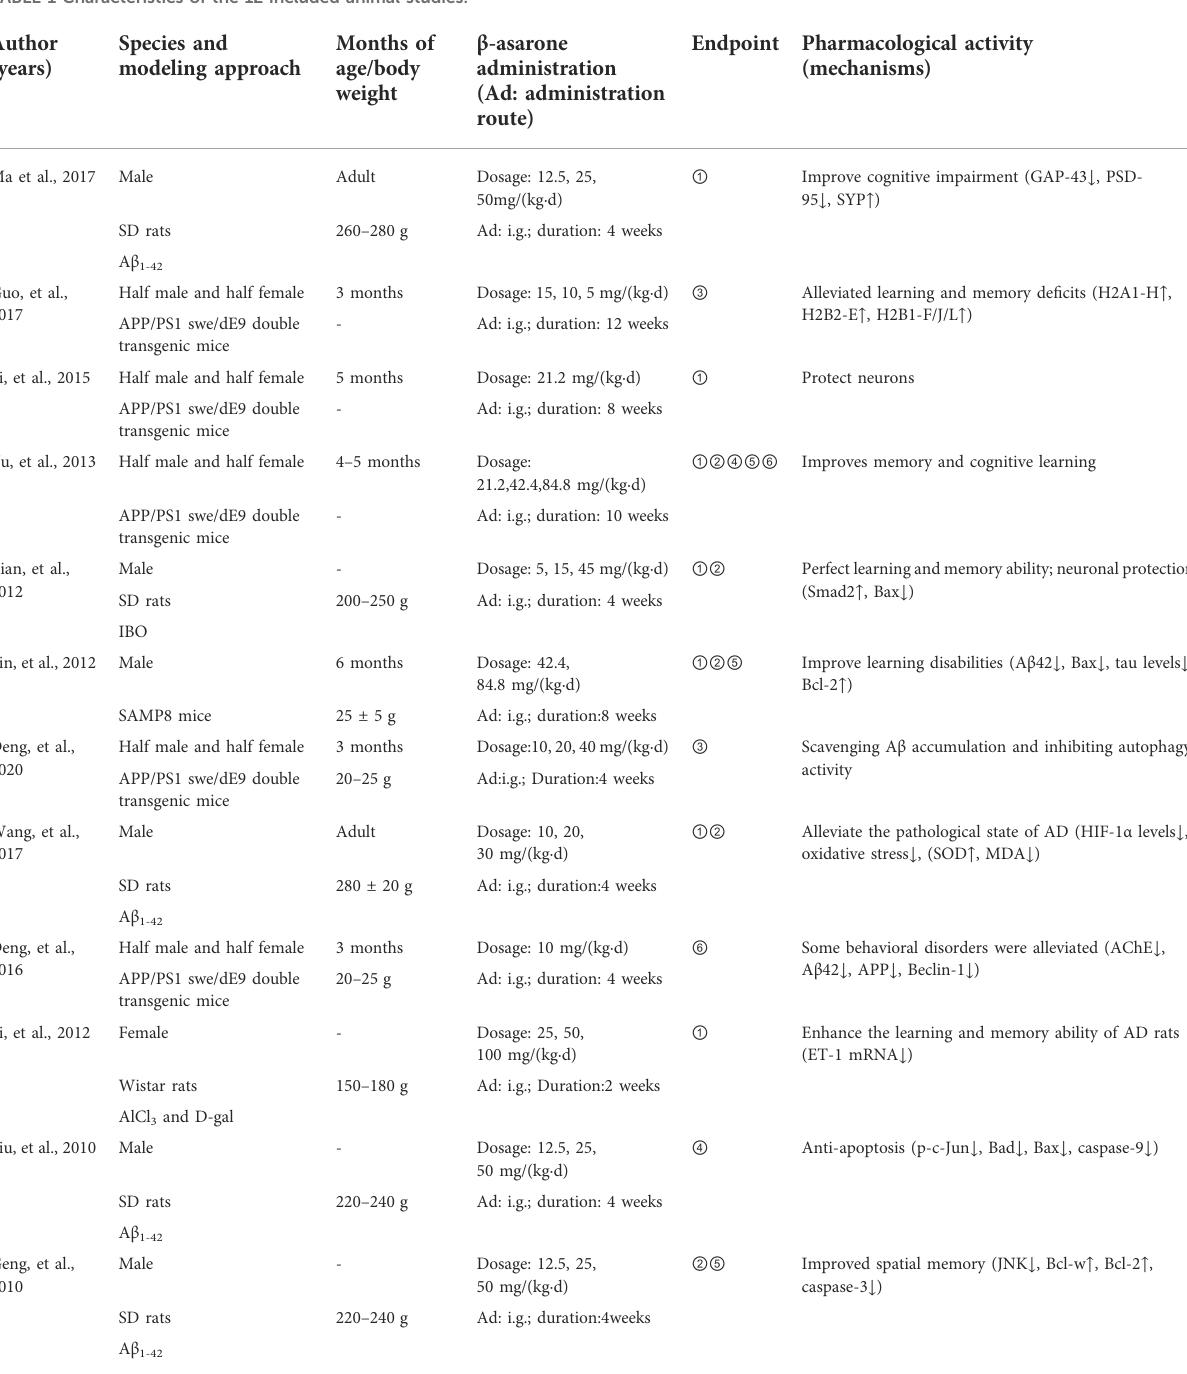
TABLE 1 Characteristics of the 12 included animal